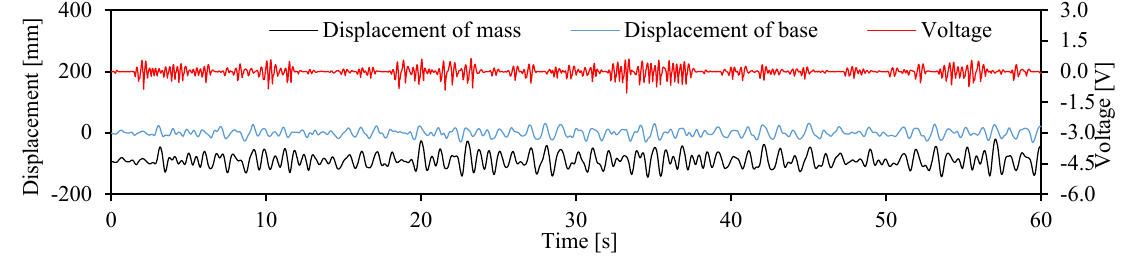
displacements of the mass block and support point, respectively; consequently, 1.04 mW of power was output.